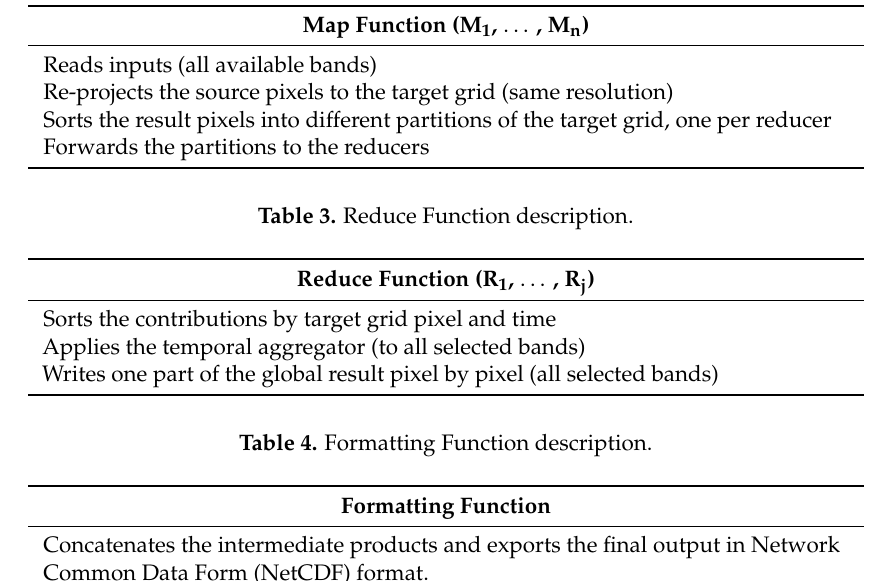
Table 2. Map Function